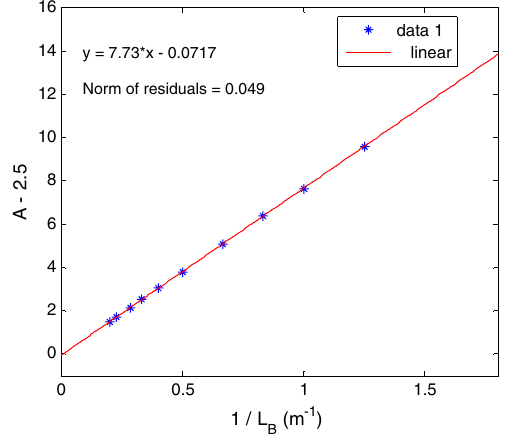
FIG. 8. Horizontal and vertical chromaticities and relative emittance " r versus the phase advance per half cell (cid:6) x for ¼ 2 m (solid lines) and 4 m (dashed lines). L B